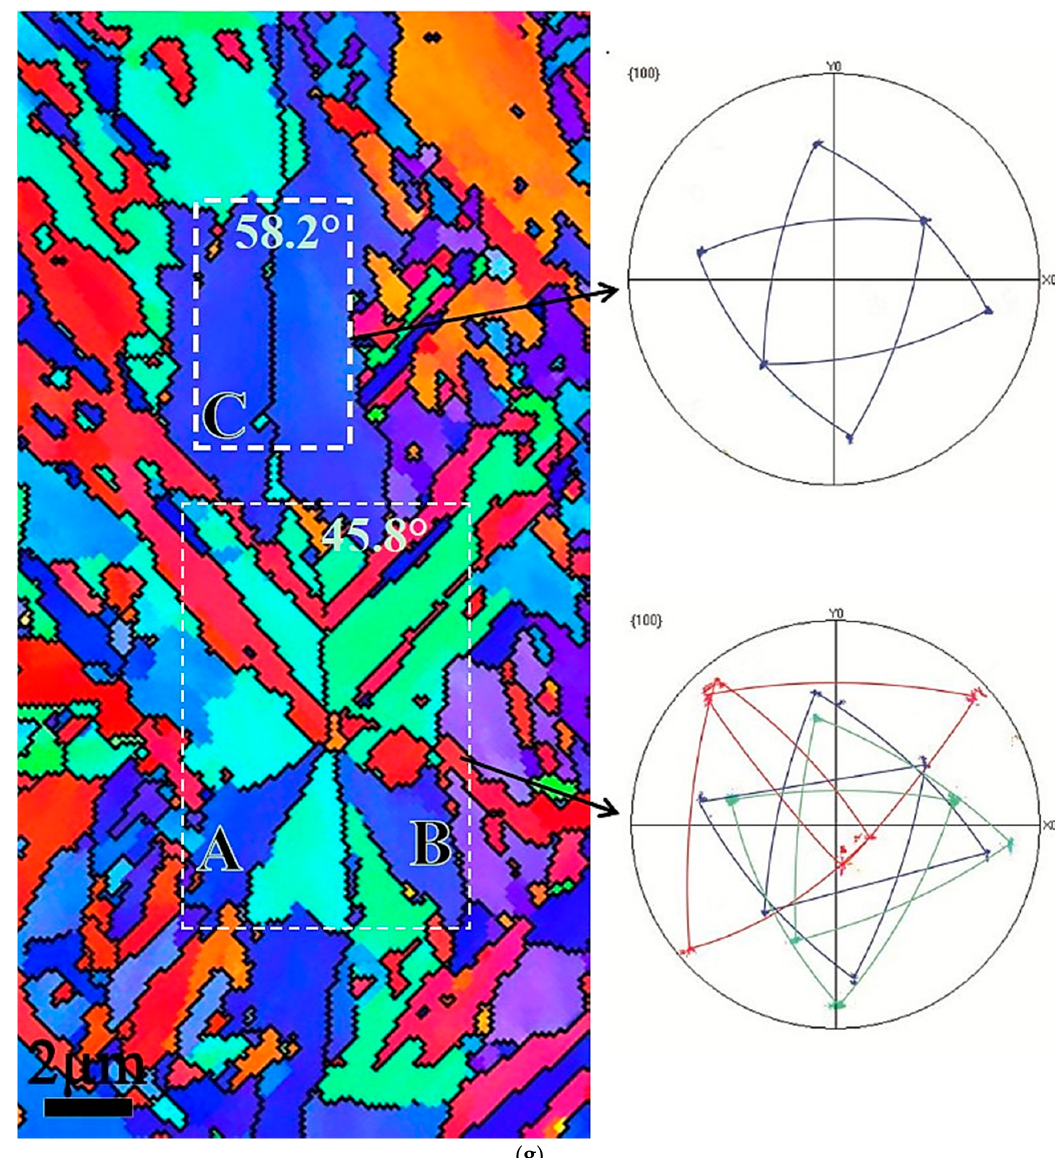
Figure 6. The forescatter detector (FSD) images ( a – c ) and the corresponding inverse pole figure maps with the pole figures (PFs) ( d – f ) at different quenching temperatures for the martensitic microstructure: ( a ) 120 °C, ( b ) 150 °C and ( c ) 190 °C. ( g ) Local morphology near the boundary and subcollection of PFs of the samples quenched at 190 °C. The black lines indicate the high-angle boundaries when the range of misorientations is 15°–63°.